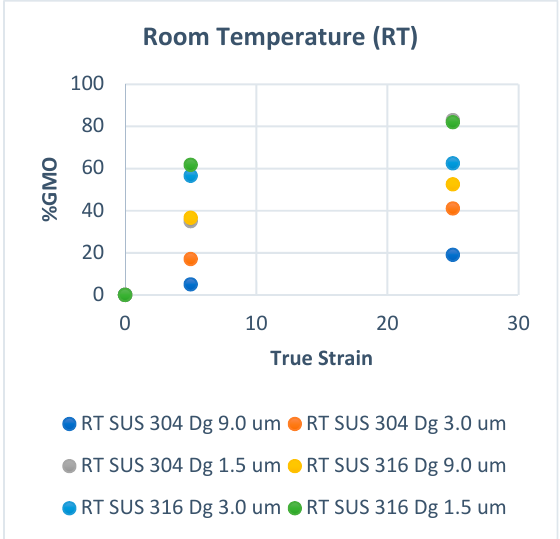
Figure 6. The FGMO at room temperature.